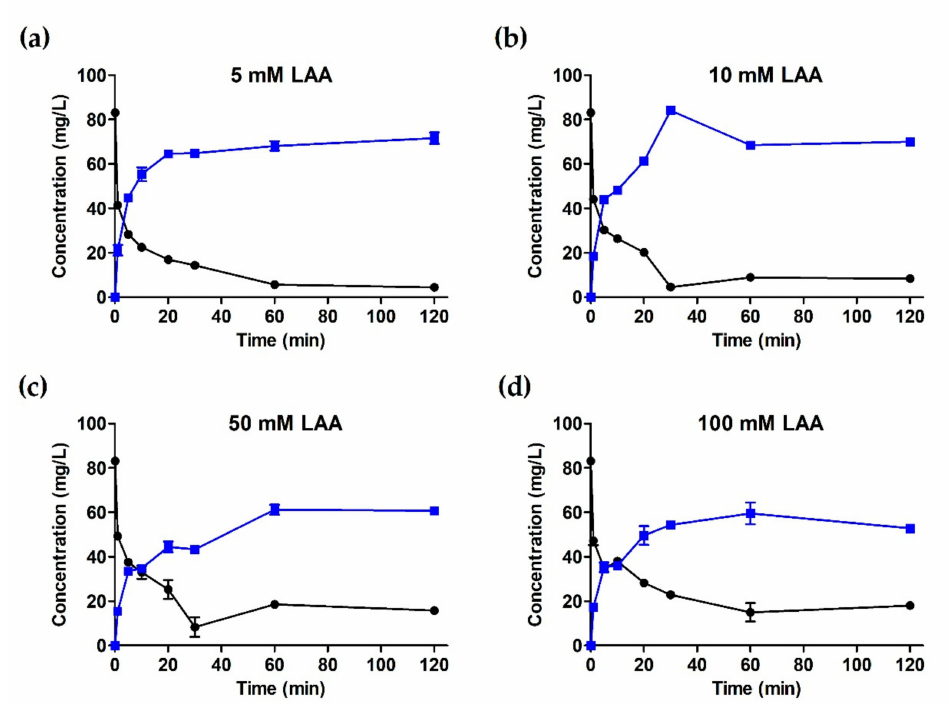
Figure 5. E ff ect of LAA concentration on the production of RD-catechol. The reaction mixtures contained five units of Ty and 500 µ M RD in 250 µ L of a 100 mM potassium phosphate bu ff er (pH 6.5) with 5 ( a ), 10 ( b ), 50 ( c ), or 100 mM LAA ( d ). The reaction mixtures were incubated at 37 ◦ C for 0–120 min. The RD-catechol produced by Ty was analyzed using HPLC. The circle ( • ) and square ( (cid:4) ) lines indicate concentration of RD and RD-catechol,